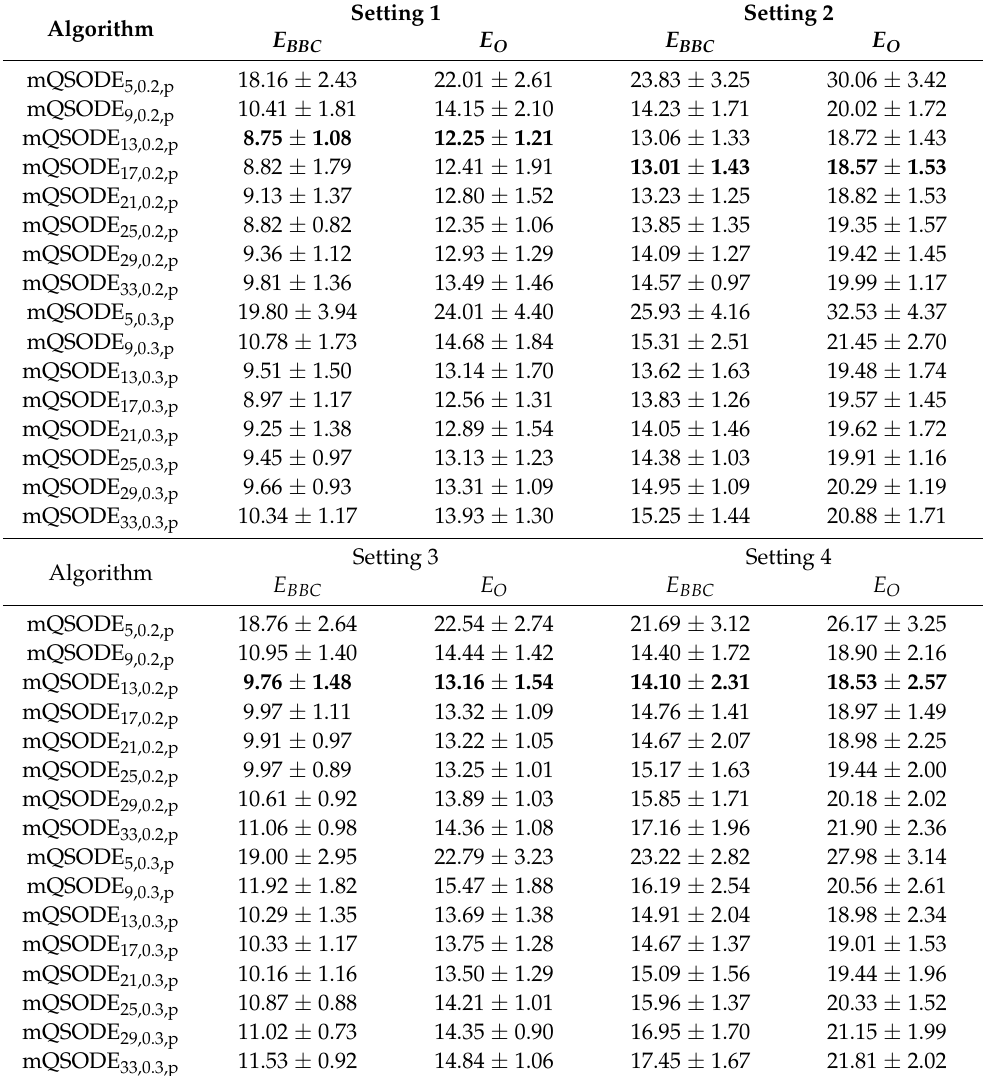
Table 5. Comparison of mQSODE, with P DE = 0.2 and P DE =